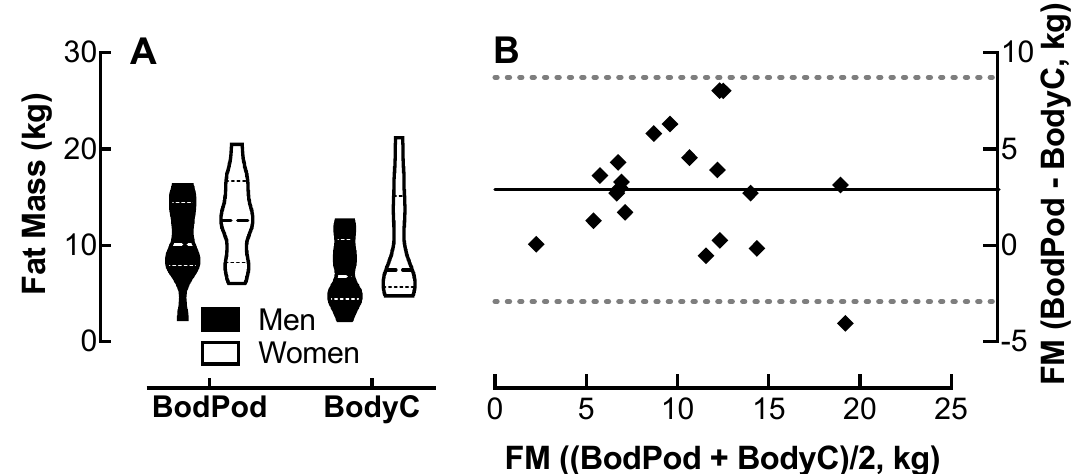
Figure 4. Comparison of fat mass (FM) measured by the Body Cardio with Bod Pod determinations. ( A ) Violin plot of FM measured by the Bod Pod and BodyC in men and women; n = 10/group. ( B ) Q- Q plot of FM determined by the Bod Pod and BodyC. Each data point represents duplicate or triplicate measures in one study participant. FM, fat mass.